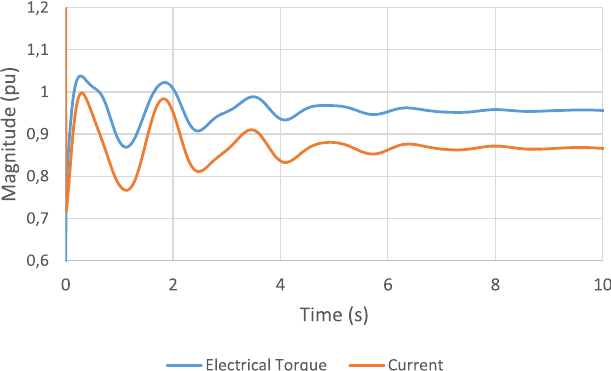
Fig. 6. Evolution of the electrical torque and the current of generator 3 after a